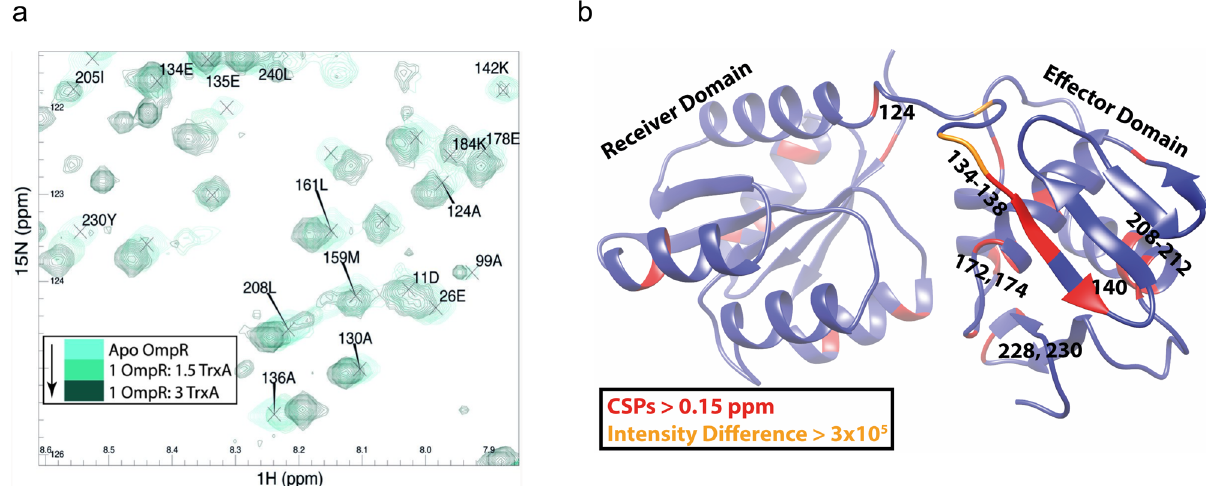
Fig.5|Identi fi cationofresiduesinOmpRthatarbitrateinteractionswithTrxA. a Regionof 15 N-HSQCspectraofapoOmpR(cyan)withincreasingamountsofTrxA (dark green). b Major CSPs and intensity changes from the 15 N-HSQC spectra are